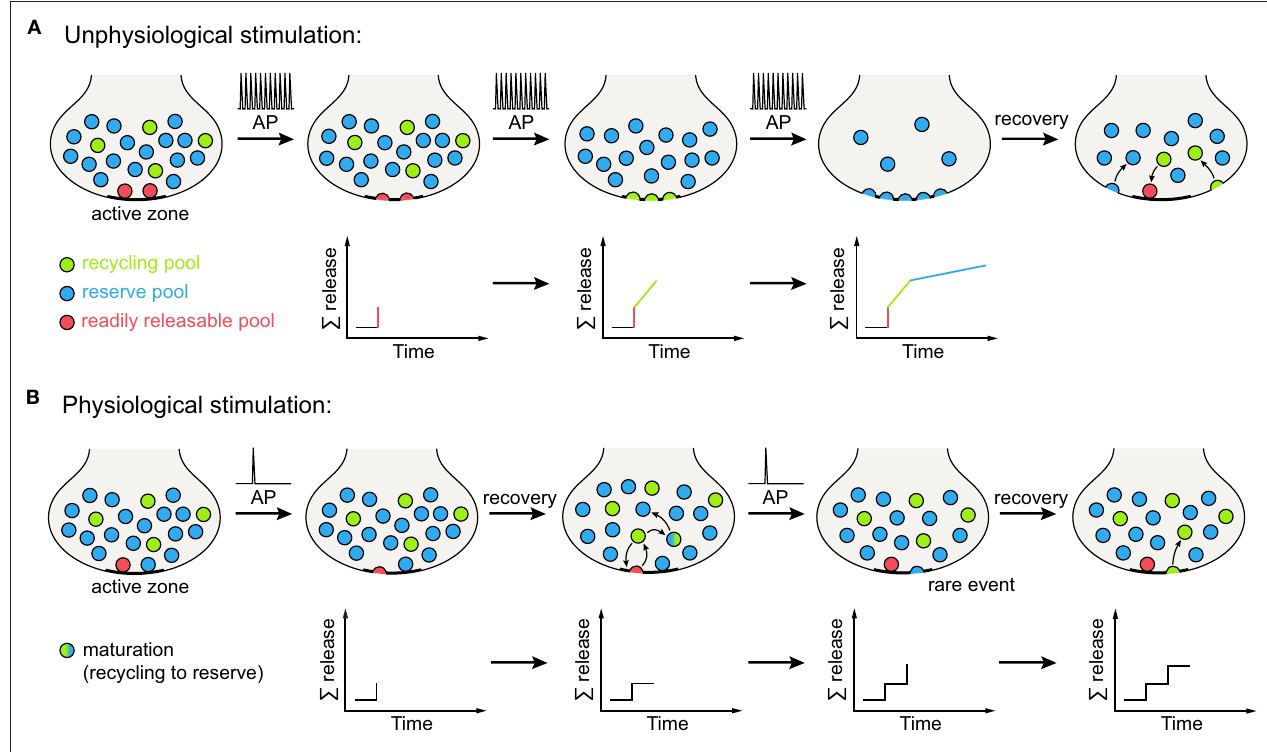
Figure 2 | Vesicle release under different stimulation conditions. (A) Unphysiological stimulation results in release kinetics in accordance with the three pool model (depicted here for spatially intermixed recycling and reserve pool vesicles, Figures 1B,C ). Upon arrival of an action potential (AP), the vesicles of the RRP (red) are released immediately. Further stimulation results in the recruitment and release of recycling pool vesicles (green), with release kinetics slower than for the RRP (as the recycling pool vesicles still need to reach the active zone and undergo docking and fusion before exocytosis). When high-frequency stimulation continues, the reserve pool vesicles are finally released (blue), displaying even slower release kinetics than the recycling pool. Therefore, a tri-phasic exocytosis process is observed. When the stimulation has ceased, vesicle components are retrieved from the plasma membrane and the three vesicle pools are reformed (vacant RRP positions are refilled as some recycling pool vesicles dock at the active zone). The lower panels